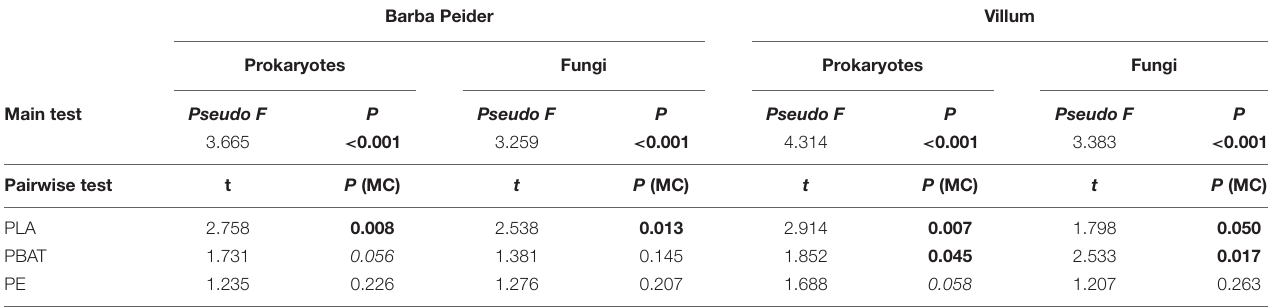
TABLE 4 | Changes in prokaryotic and fungal community structures in the plastisphere. Barba